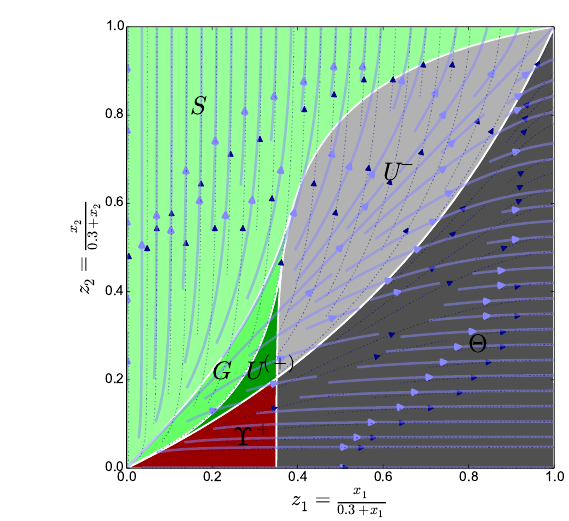
Figure 6. Substitution of a dirty technology. Coevolution of the cumulative production of a dirty technology ( x 1 ) and a clean one ( x 2 ) without (pale-blue curves) and with (dotted dark-blue curves) a subsidy for the clean technology. Undesired region with too high future usage of the dirty technology coloured in grey. Knowledge stocks x 1 , 2 were transformed to z 1 , 2 = x 1 , 2 / (0.3 + x 1 , 2 ) in order to capture their divergence to +∞